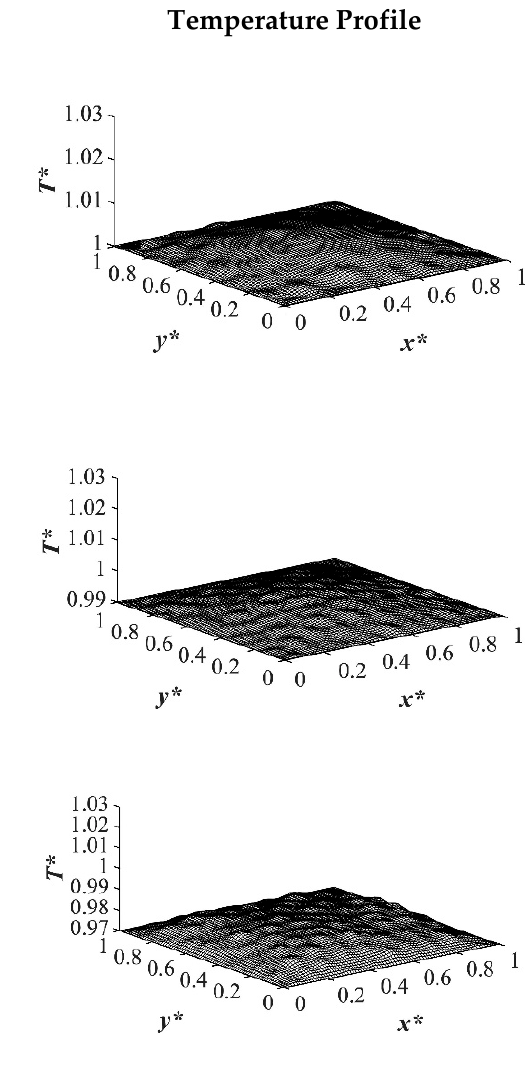
Figure 8. Spatial concentration ( left column) and temperature ( right column) profiles for the off- critical quench to c * = 0.909 at t * = 3.01 × 10 − 4 for three different quench depths of ( a ) T * q1 = 1.0, ( b ) T * q2 = 0.99 ( c ) T * q3 = 0.97.